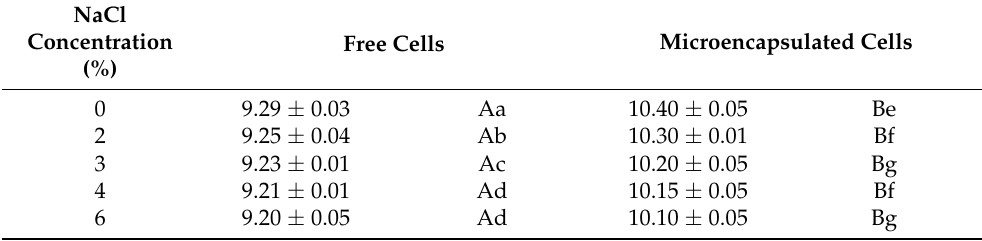
Table 5. Effect of NaCl concentrations on the viability of free and encapsulated (alginate+xanthan gum) L. rhamnosus microcapsules (log cfu mL − 1 ). NaCl Free